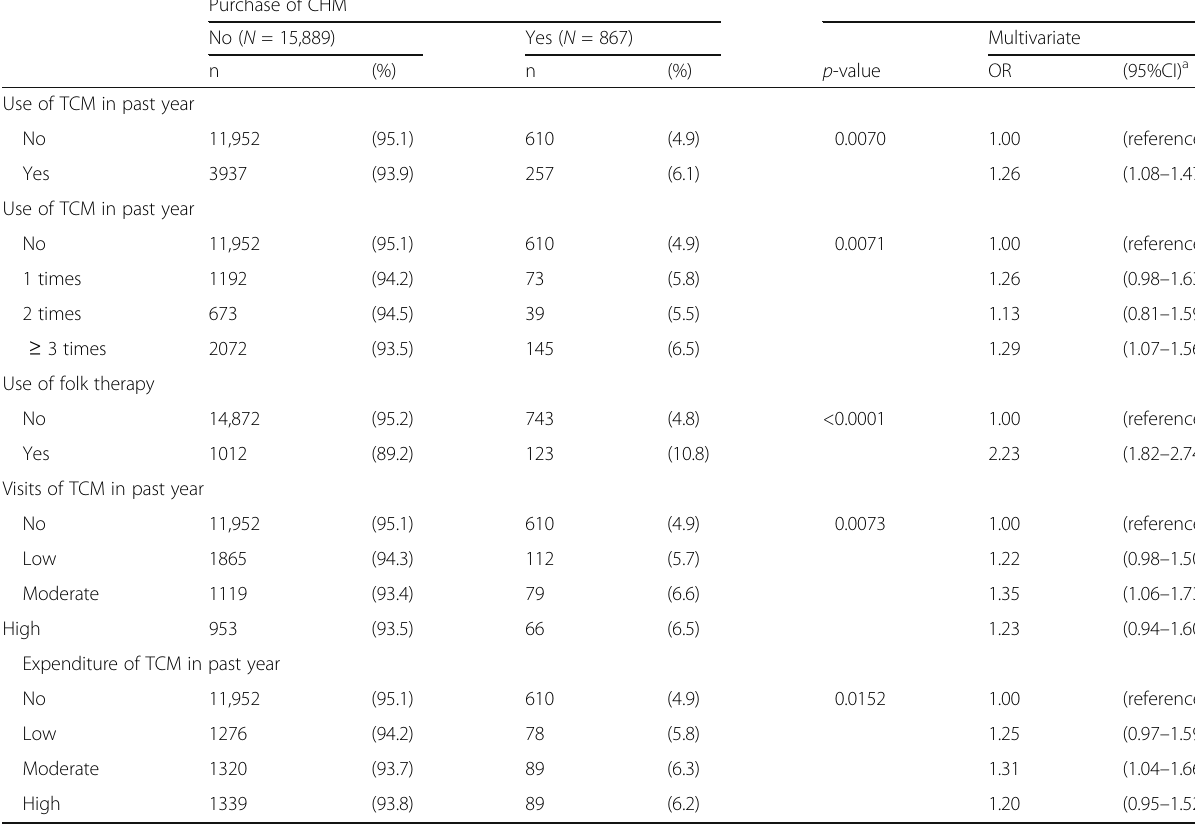
Table 3 Medical care visit of TCM for people with and without purchasing CHM